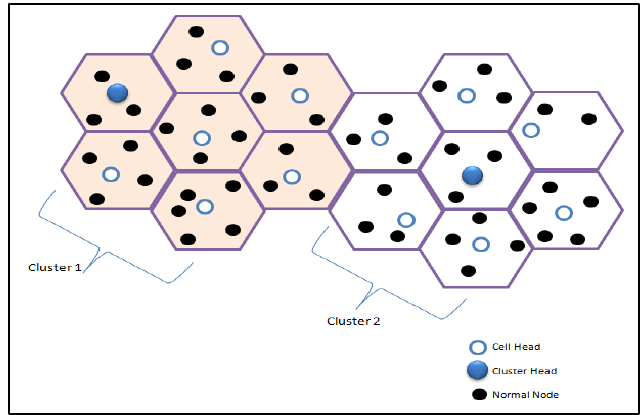
Figure 6. Cells and clusters.